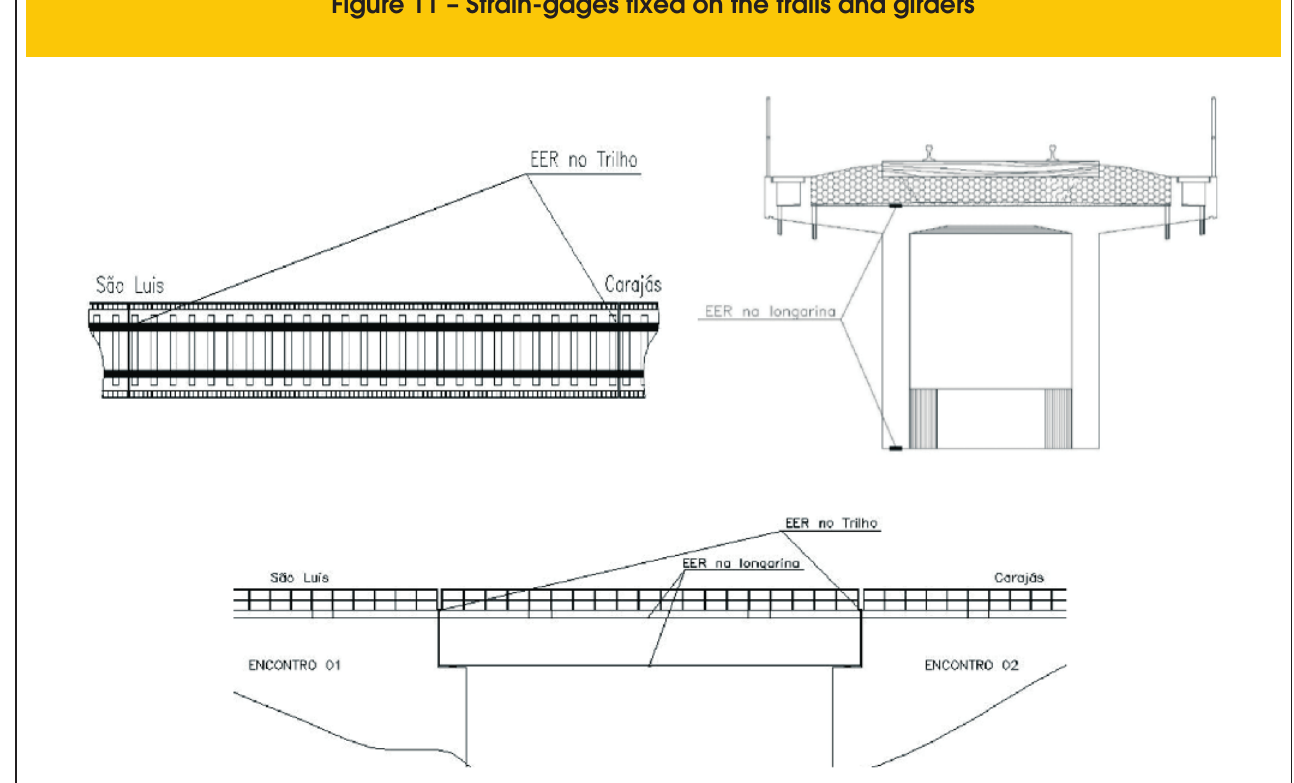
Figure 11 – Strain-gages fixed on the trails and